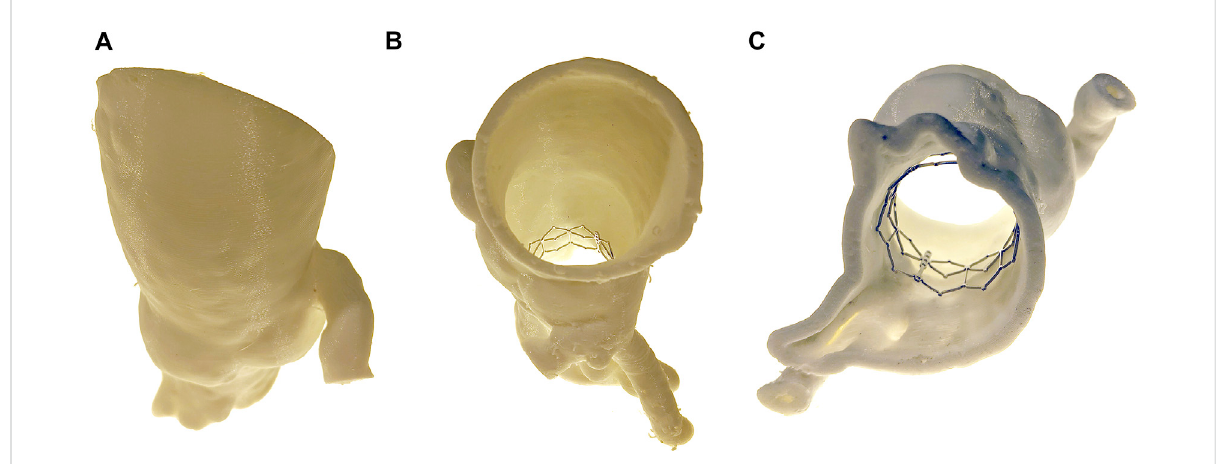
FIGURE 2 3DPrintedPhantom.A3Dprintedphantomwasgeneratedfromthepatientpreoperativeimaging.Theanatomywassegmentedfromthedistal end of the LVOT to the proximal aorta. A TAVR cage was then inserted into the phantom and the entire phantom was reimaged. Views include (A) anterior, (B) superior, and (C)